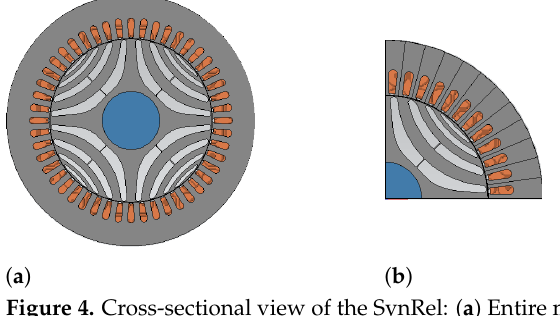
Figure 4. Cross-sectional view of the SynRel: ( a ) Entire machine; ( b ) One pole.